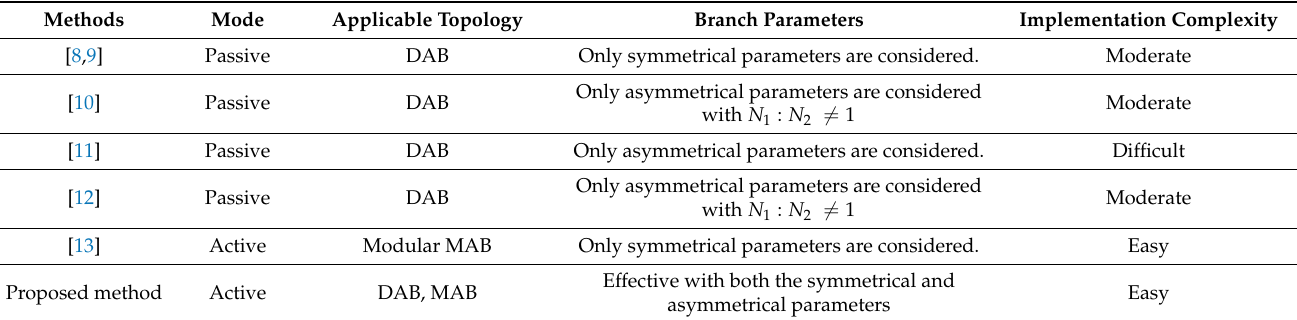
Table 2. Overall comparison with other methods.